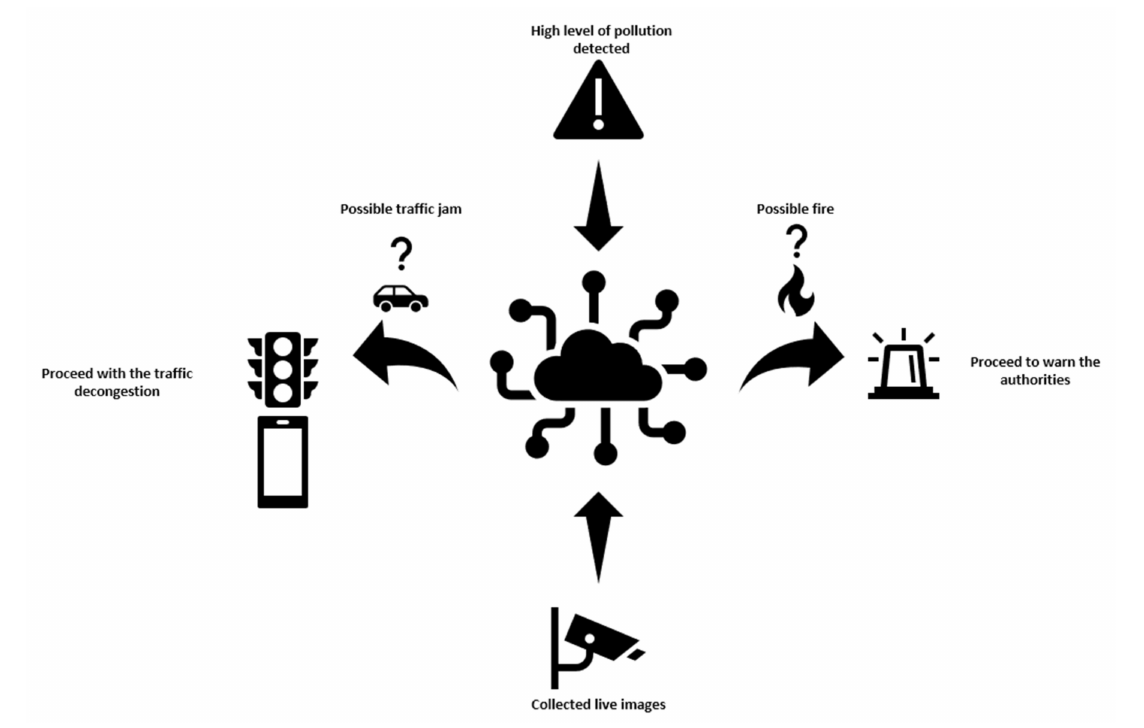
Figure 2. Graphic presentation of the complex system at